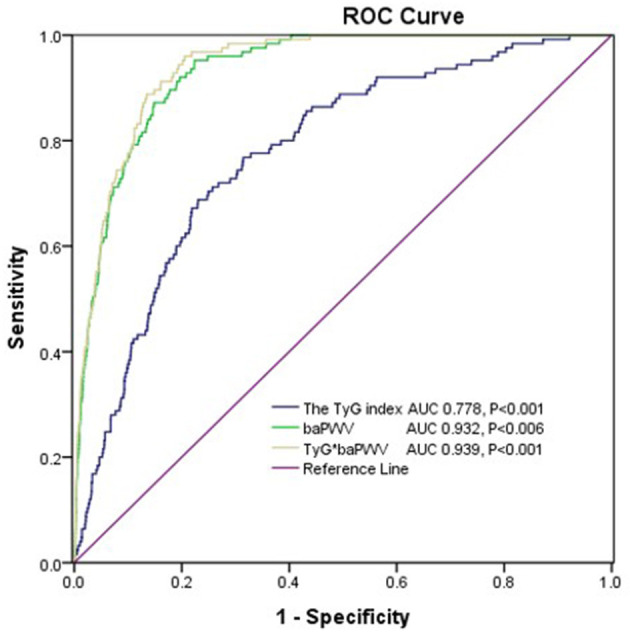
The areas under the ROC (AUROCs) of the TyG index, baPWV, and TyG-baPWV for predicting 10-CVD risk in women.